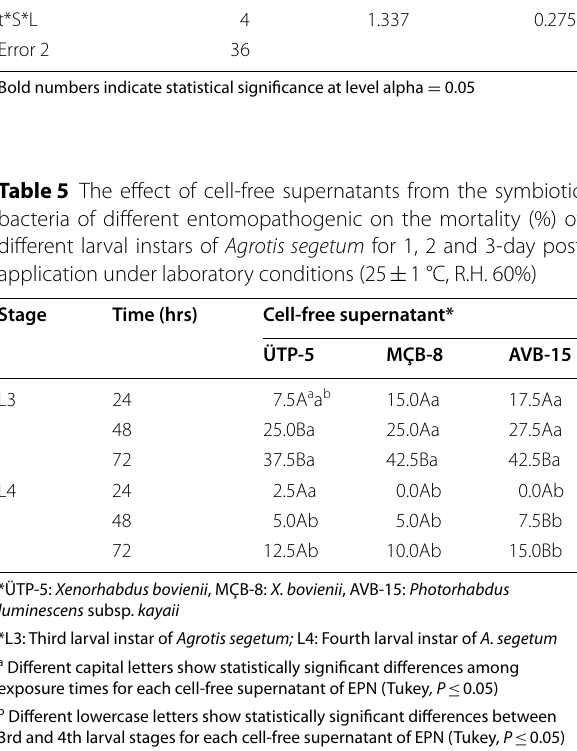
Table 6 ANOVA results for the main effects and associated interactions for the mortality levels of 3rd and 4th larval instars of Agrotis segetum for the contact efficacy of cell-free supernatants df